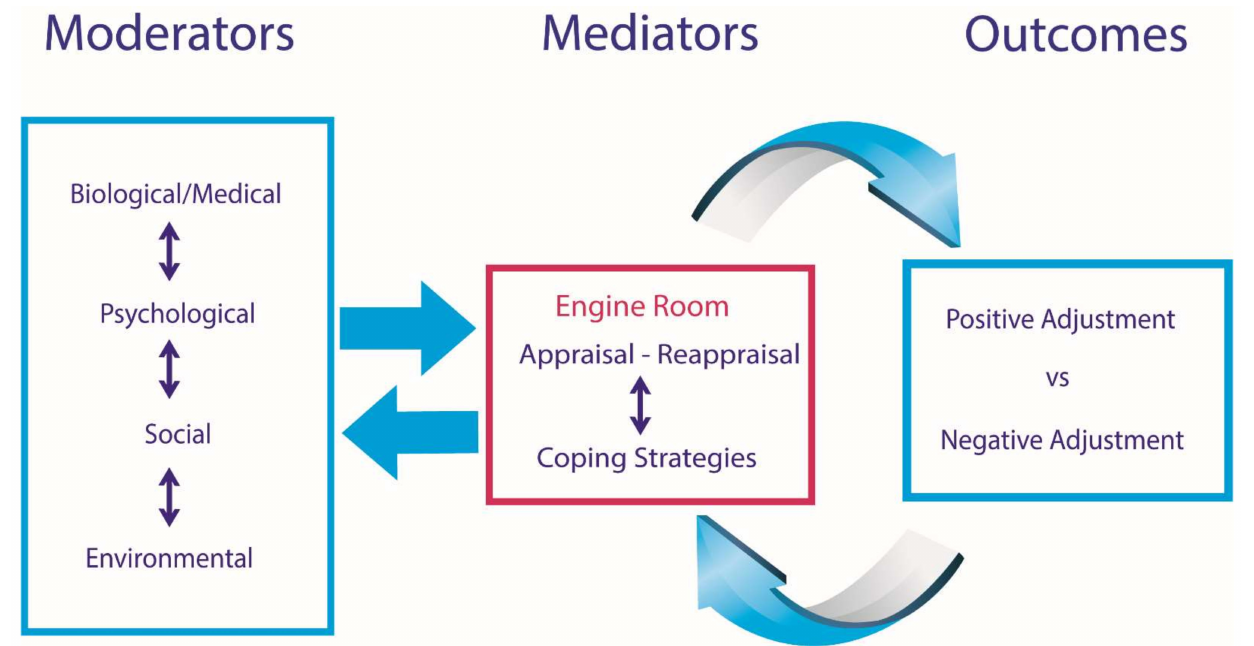
Figure 1. A simplified version of SCIAM (so that mediation analyses can be applied). Moderators will consist of multiple predisposing and modifying factors including age, sex, personality, injury severity, secondary conditions, religious and cultural views, employment and finances, policy and compensation, general self-efficacy and self-esteem, medications, and relationships. Moderators will influence mediators and vice versa. Mediators consist of appraisals and re-appraisals of life challenges and resultant coping strategies. There is a reciprocal influence between perceptions and coping